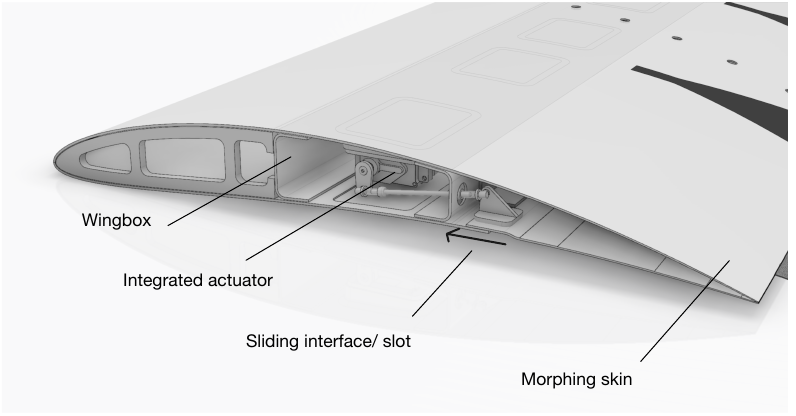
Figure 1. SmartX slow morphing concept: the trailing edge can seamlessly move up and down. The SmartX hardware technology integrator is equipped with six trailing edge